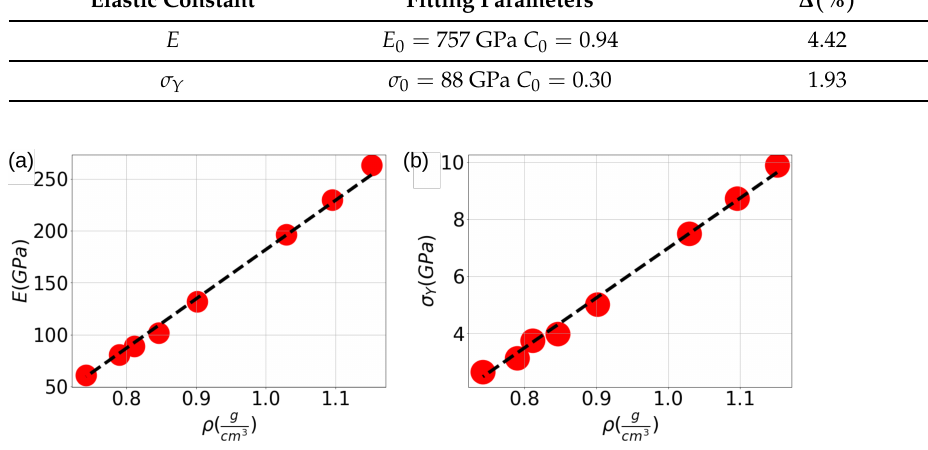
Figure 3. Comparison of MD results (red points) with theoretical models (lines) for Young’s modulus ( a ) and yield stress ( b ) during the foam fracture process respect to % sp 3 . Table 2. Elastic constants and fitting parameters with the corresponding errors. Elastic Constant